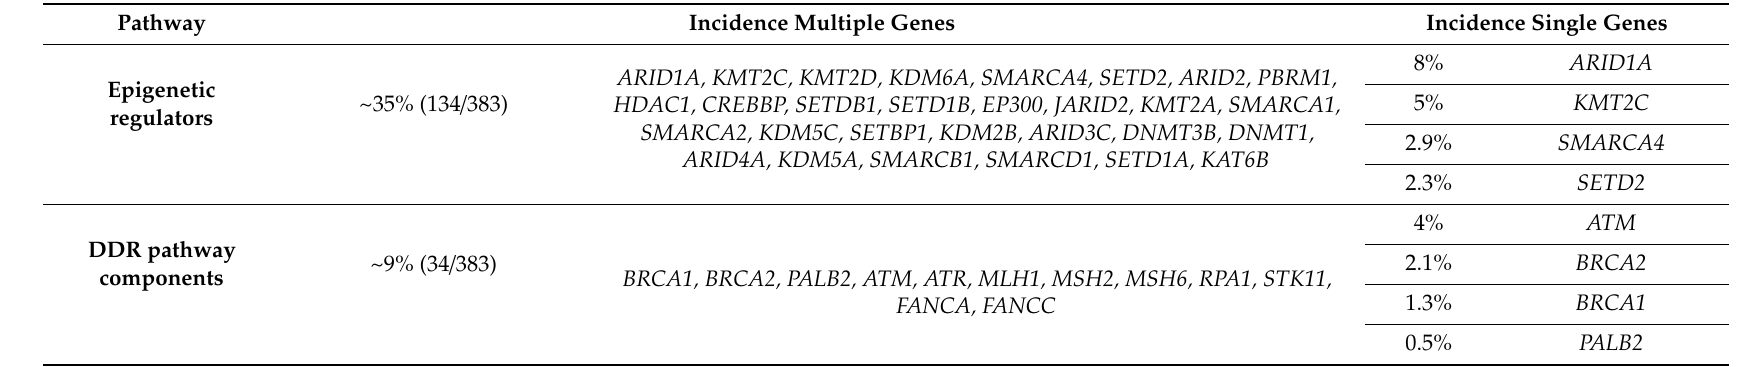
Table 1. Mutation frequency of coherent pathway components in PDAC patients. Data according The Cancer Genome Atlas (TCGA) dataset pancreatic